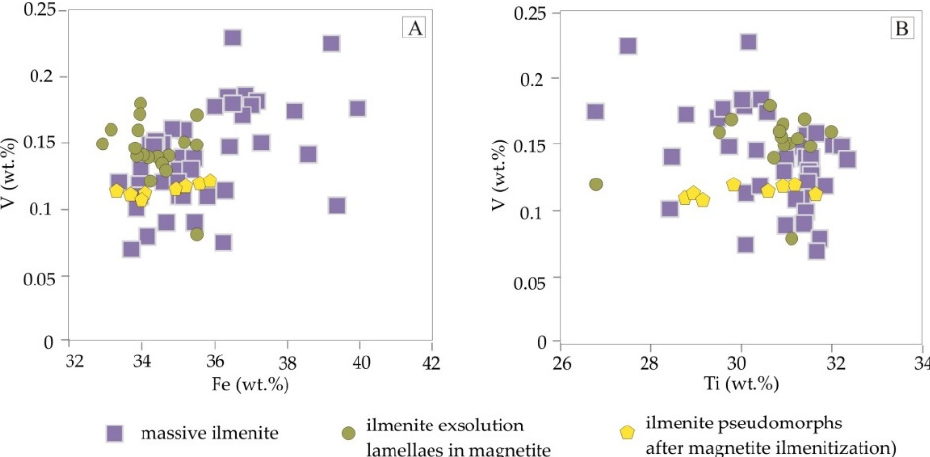
Figure 15. Bivariate diagrams of vanadium vs. iron ( A ) and vanadium vs. titanium ( B ) in ilmenite depending on crystal form in the Krzemianka and Udryn Fe-Ti-V deposits. All plots represent the same set of samples; 0 values and samples with values below the level of precision of a single measurement are not presented on the axis.